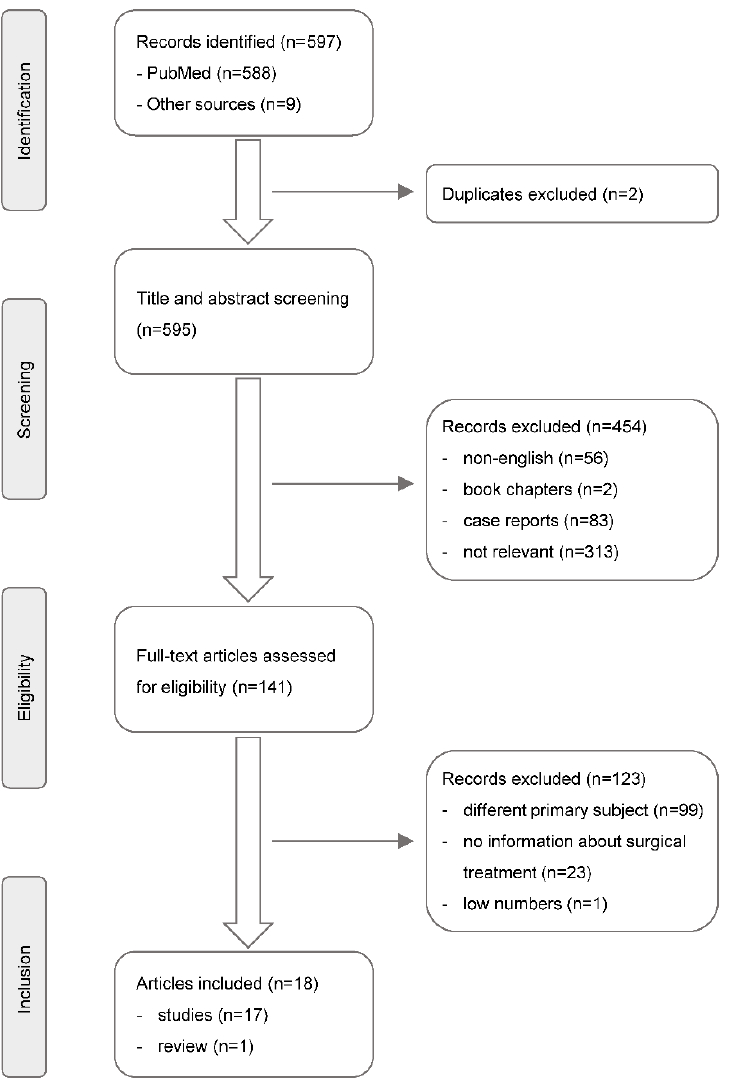
Figure 1. Evaluation of literature. After database search and cross-checking of bibliographies (see text), relevant studies were identified following the Preferred Reporting Items for Systematic Reviews and Meta-Analyses (PRISMA) guidelines.